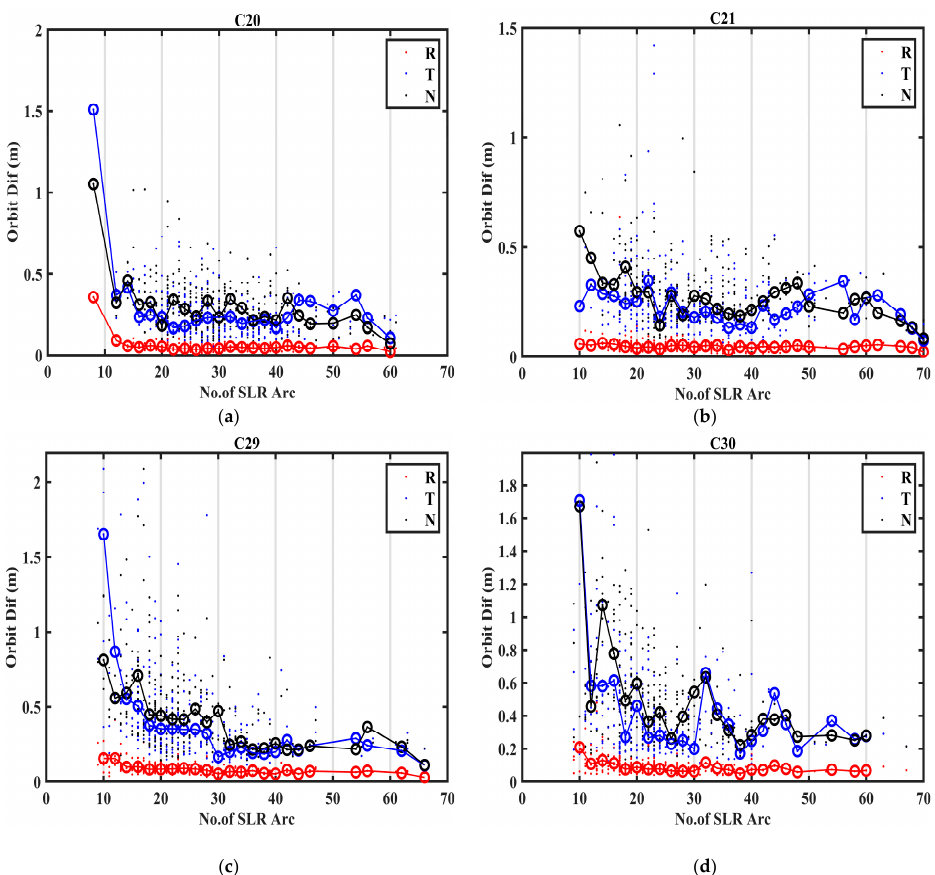
Figure 7. The relationship between the number of SLR observations and the median RMS values is shown by the red, blue, and black dots, which correspond to the RMS values in the R, T, and N directions, respectively. In addition, the median RMS values are indicated by a hollow circle, with a step size of 2. Subplot ( a – d ) represents C20, C21, C29, and C30 satellites, respectively. Figure 8 shows how the RMS for 9-day solutions depends on the number of SLR stations. The C20 and C21 satellites have a maximum of 14–15 SLR stations, and there are 13 SLR stations for the C29 and C30 satellites in their 9-day arc, respectively. At least 3–5 SLR stations are necessary to determine an orbit e ff ectively. Additionally, the accuracy of the multi-day arc solutions increases with the number of SLR stations. For C20 and C21 satellites, the POD results improve and become steadier when there are more than 6–8 SLR stations. The geographic distribution geometry of SLR stations is strengthened as the number of SLR stations rises, improving the accuracy of the SLR-only orbit determination, particularly in the T and N directions, especially for C29 and C30 satellites.